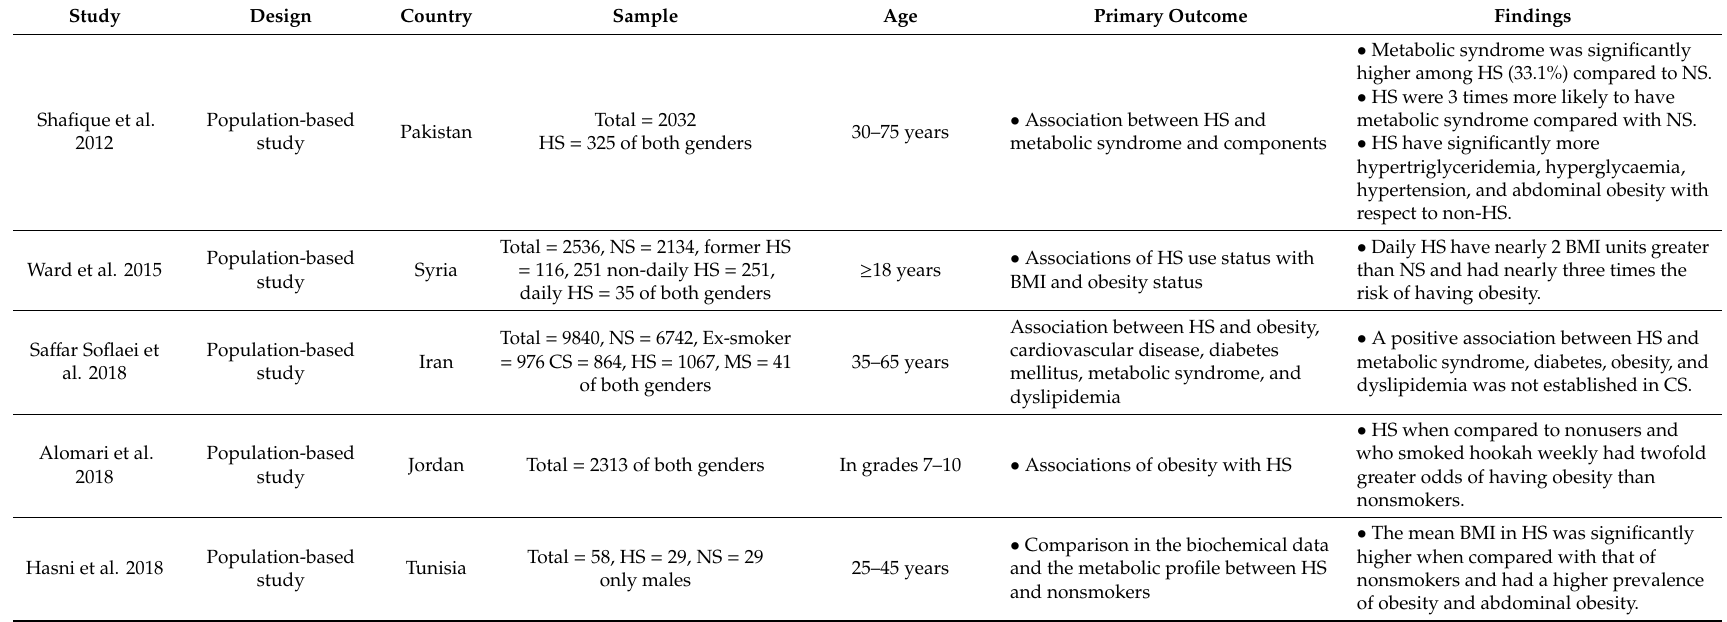
Table 1. Summary of the included